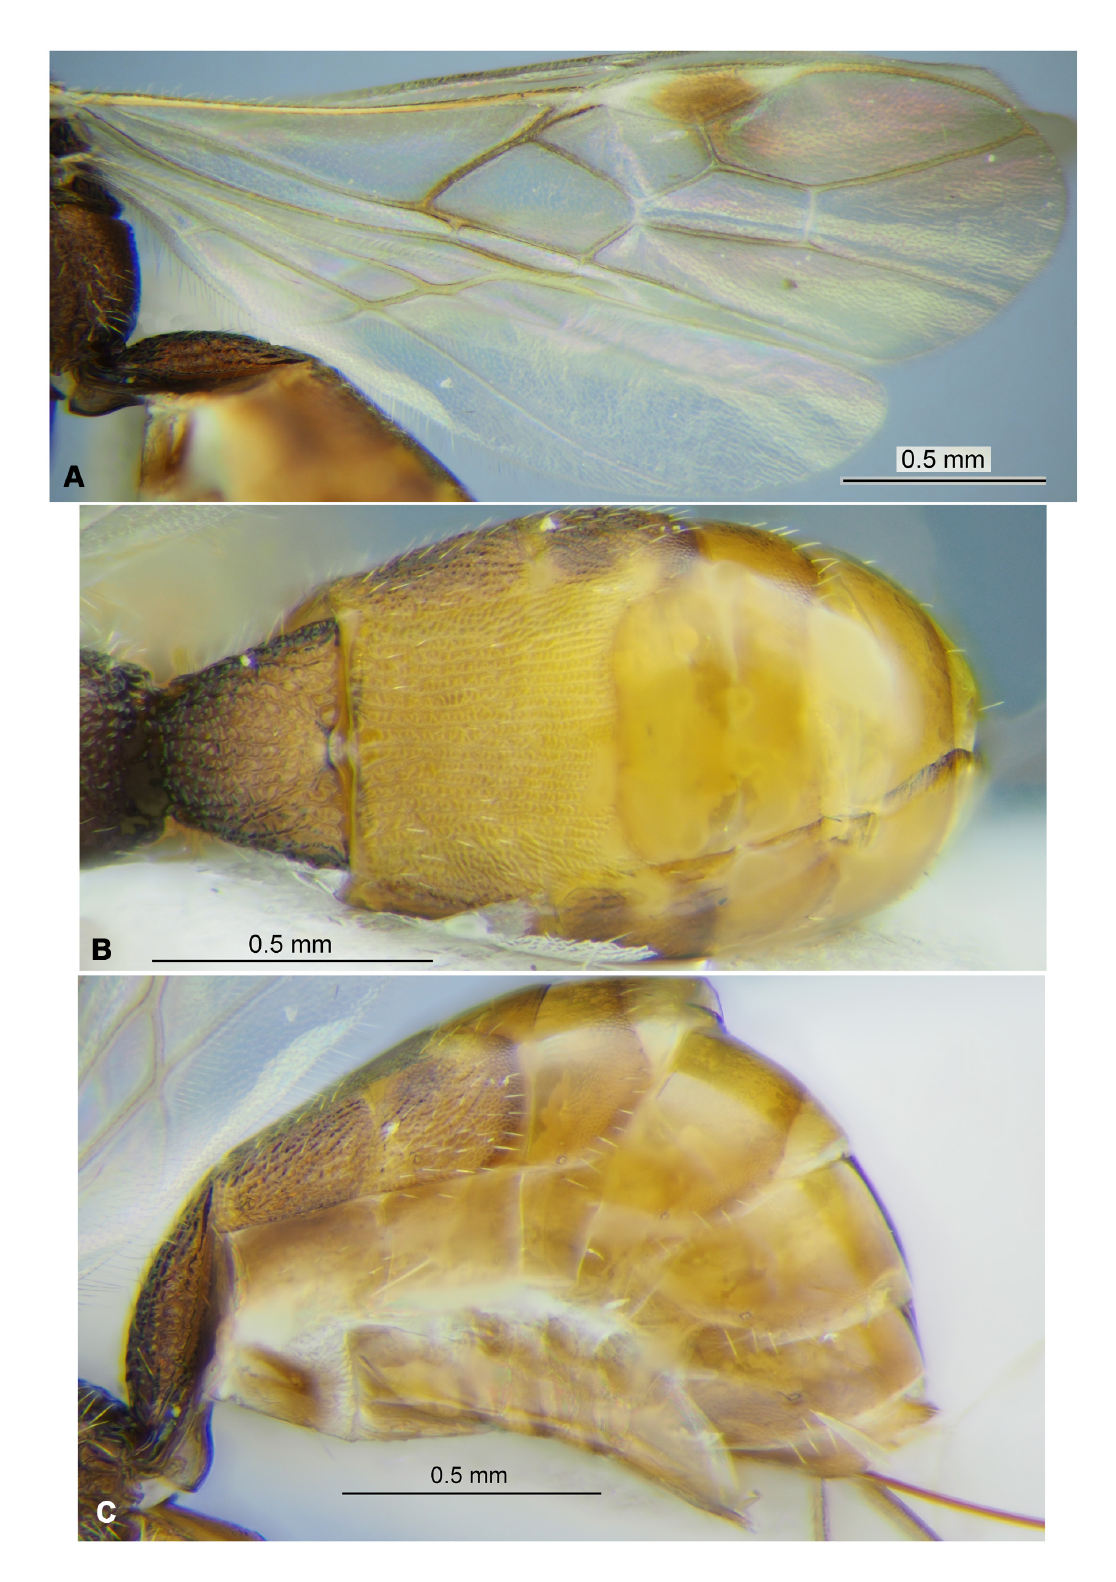
Fig. 2. Dendrosotinus ( Dendrosotinus ) ferrugineus (Marshall, 1888), ♀ (RMNH). A . Wings. B . Metasoma, dorsal view. C . Metasoma, lateral